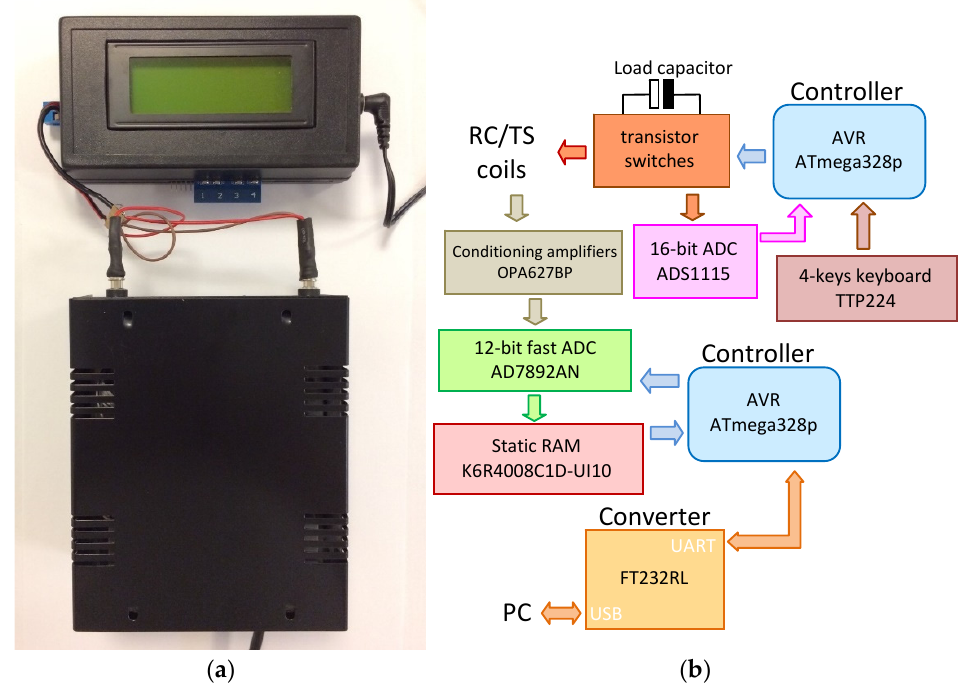
Figure 11. The control system and the measurement system: ( a ) Photograph; ( b ) Schematic diagram.